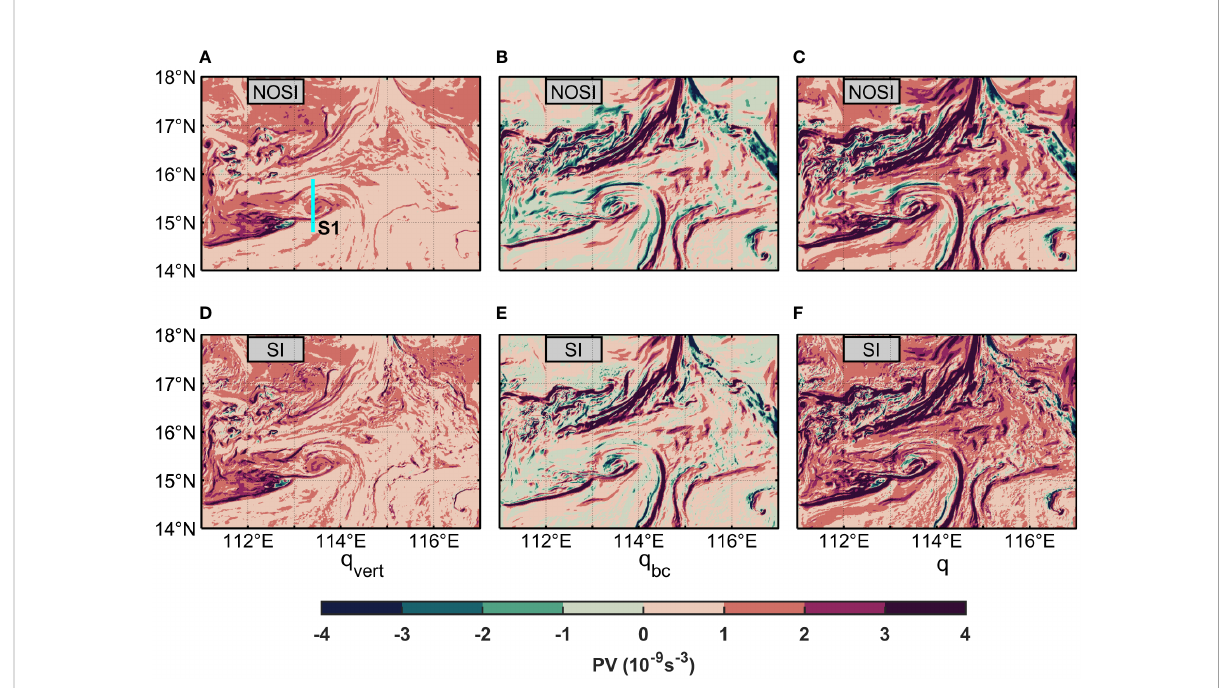
FIGURE 13 Comparison of the near-surface (at 5m water depth) Ertel PV q and its sub-components in different cases. The panels (A – F) show snapshots in R1_NOSI (R1_SI) at the same time as Figure 3. The panels (A , D) are the vertical vorticity component of Ertel PV. The panels (B , E) are the baroclinic component of Ertel PV. The panels (C , F) are the Ertel PV. The S1 is selected for analyzing the vertical distribution of Ertel PV. PV, potential